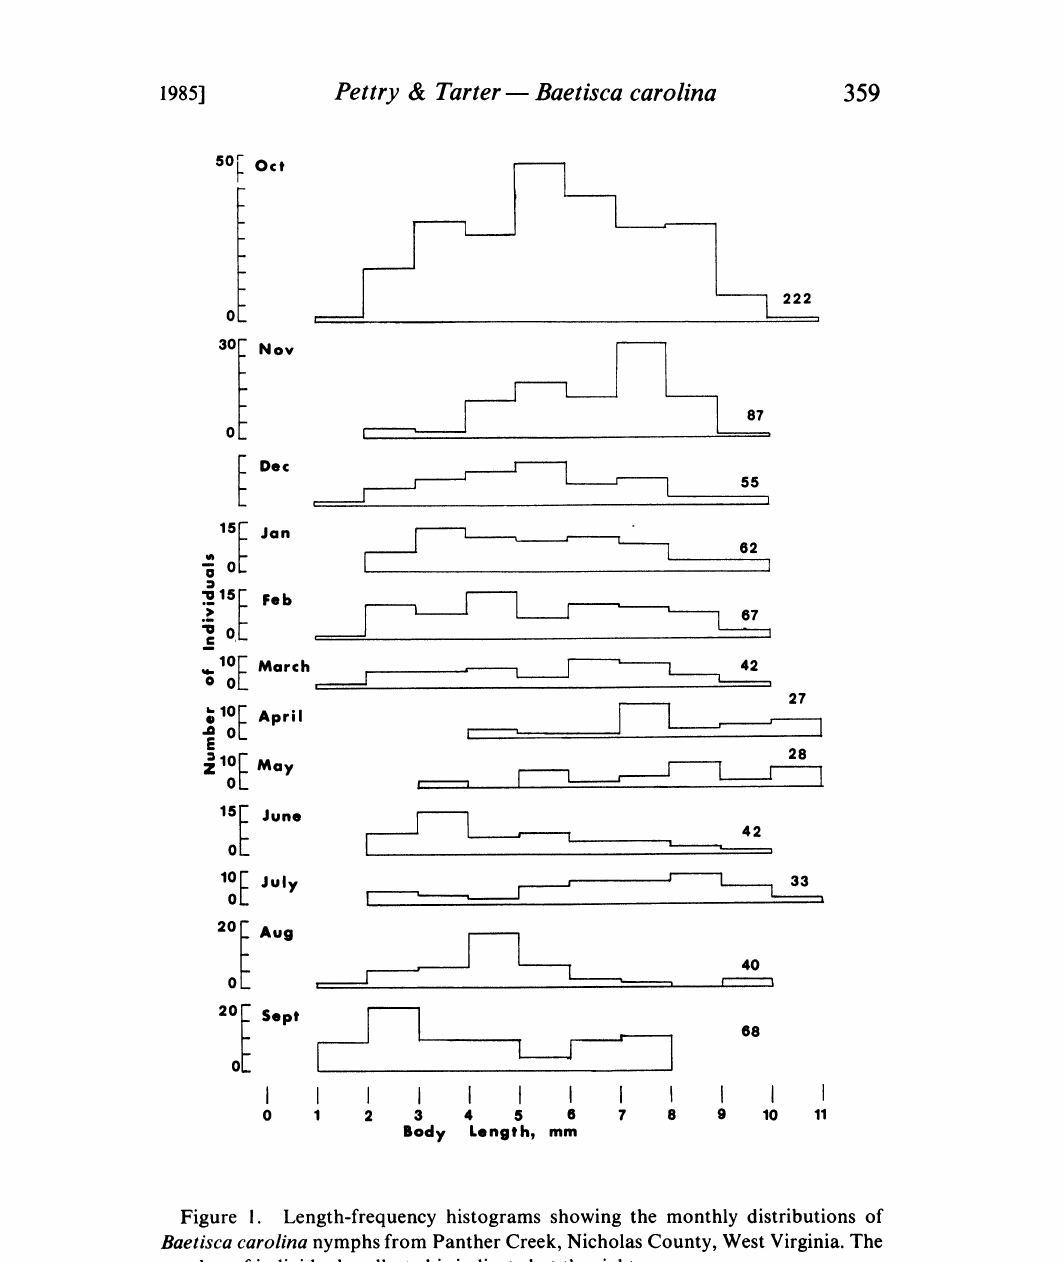
Figure I. Length-frequency histograms showing the monthly distributions of Baetisca carolina nymphs from Panther Creek, Nicholas County, West Virginia. The number of individuals collected is indicated at the